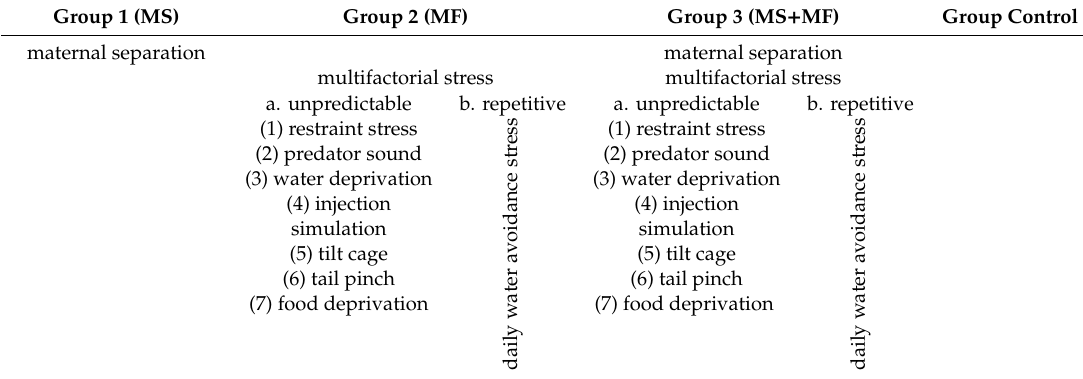
Table 1. The types of stressors applied in each experimental group of